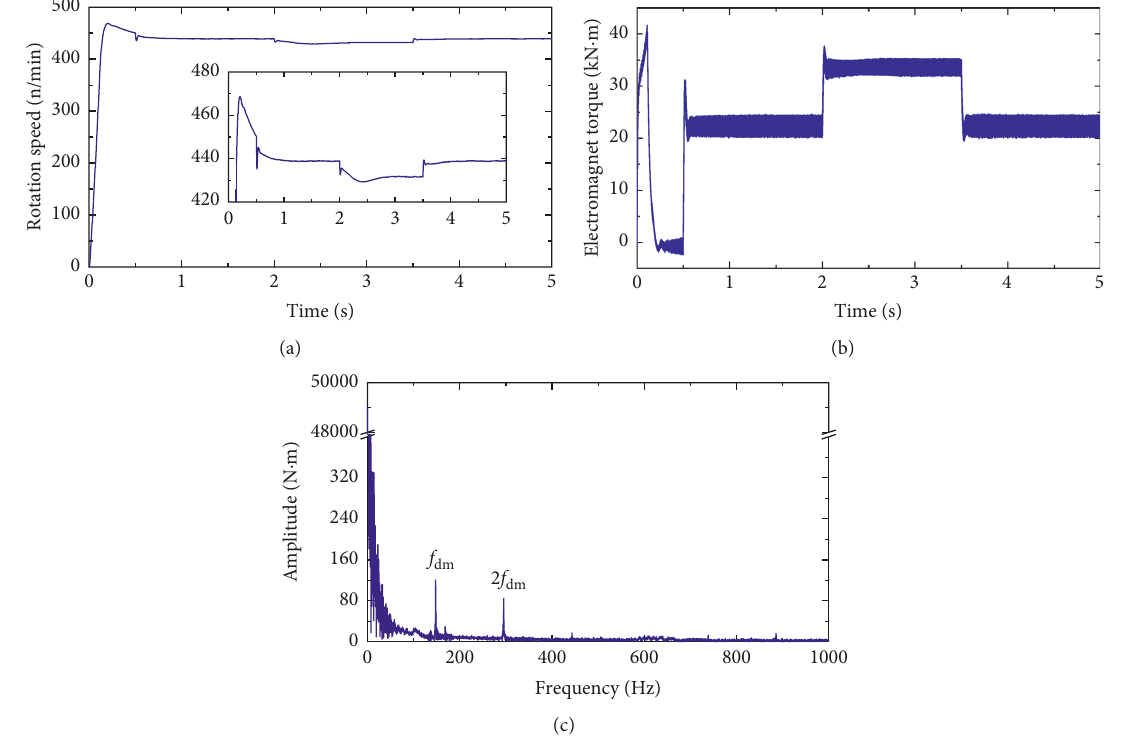
Figure 11: Simulated results of hoist motor. (a) Rotational speed. (b) Driving torque. (c) Frequency-domain curve of driving torque.